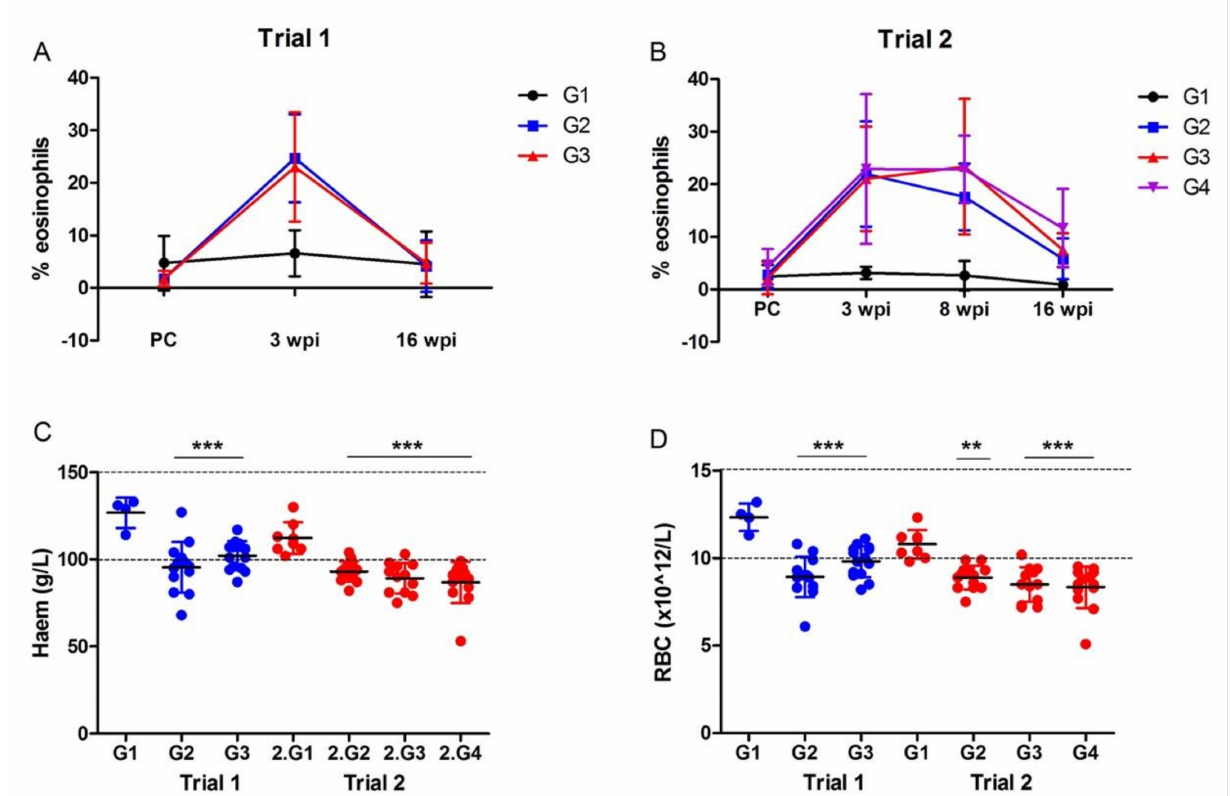
Figure 2. Profile of haematological parameters during F. hepatica infection. ( A , B ) Eosinophilia during the vaccine trial time-course represented as a percentage of the total cells. ( A ) In Trial 1, blood samples were taken post-vaccination/pre-challenge with F. hepatica metacercariae (PC), 3 wpi and 16 wpi. ( B ) In Trial 2, blood samples were taken post-vaccination/pre-challenge with F. hepatica metacercariae (PC), 3 wpi, 8 wpi and 16 wpi. Data represented at ± standard deviation. ( C ) Levels of haemoglobin measured as g/L in blood samples taken at 16 wpi from Trial 1 (blue) and Trial 2 (red), represented at ± standard deviation. Normal values typically range between 100 and 150 g/L as shown by the two lines. ( D ) Number of red blood cells (RBC; × 10 12 /L) in blood samples taken at 16 wpi from Trial 1 (blue) and Trial 2 (red), represented at ± standard deviation. Normal values typically range between 10 × 10 12 /L and 15 × 10 12 /L as shown by the two horizontal-dashed lines. G1, control unvaccinated, uninfected; G2, control unvaccinated, infected; G3 and G4, vaccinated, infected. ** p < 0.01 and *** p < 0.001 relative to the values obtained from the non-vaccinated, non-infected group (G1) in each